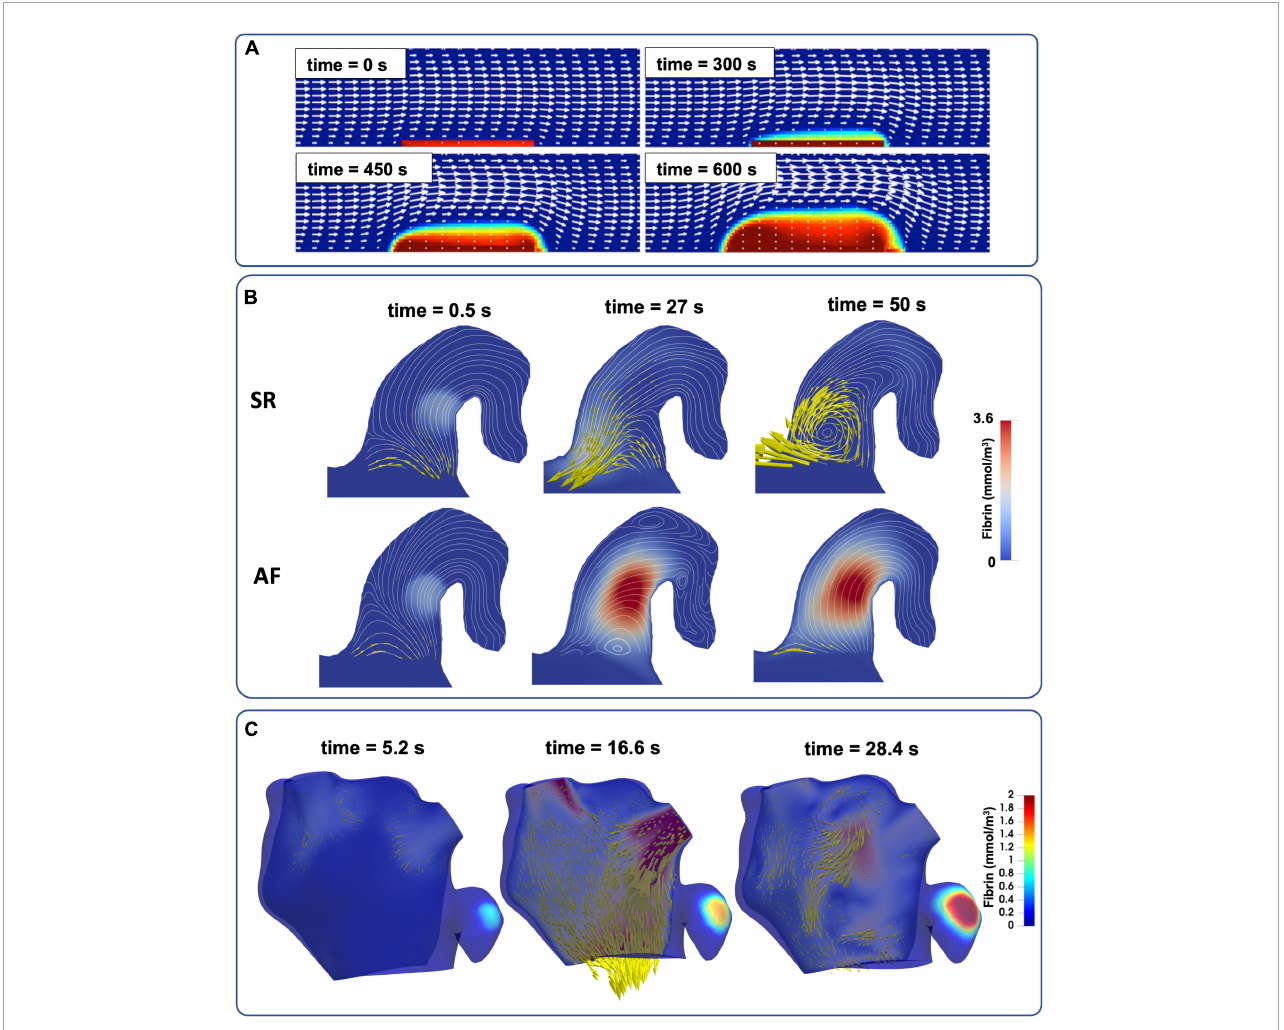
FIGURE5 The evolution of full RDC-based thrombus models coupled with blood flow. (A) Simple 2D channel with white arrows representing velocity and red regions as bound platelets concentration at the thrombus (77). (B) Semi-realistic 2D contracting chicken wing LAA model in both AF and SR conditions with yellow arrows to represent blood velocity and red region as fibrin gel formation (86). (C) Patient-specific 3D LA models of LA flow with thrombin concentration representing the thrombus (see also Supplementary video 1